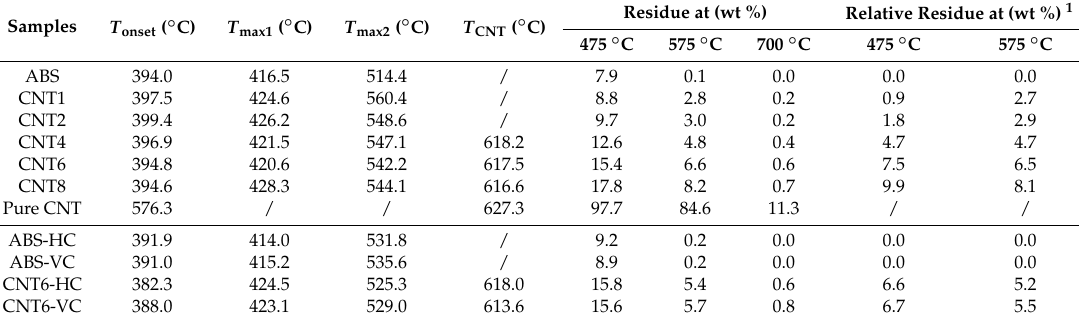
1 calculated according to Equation